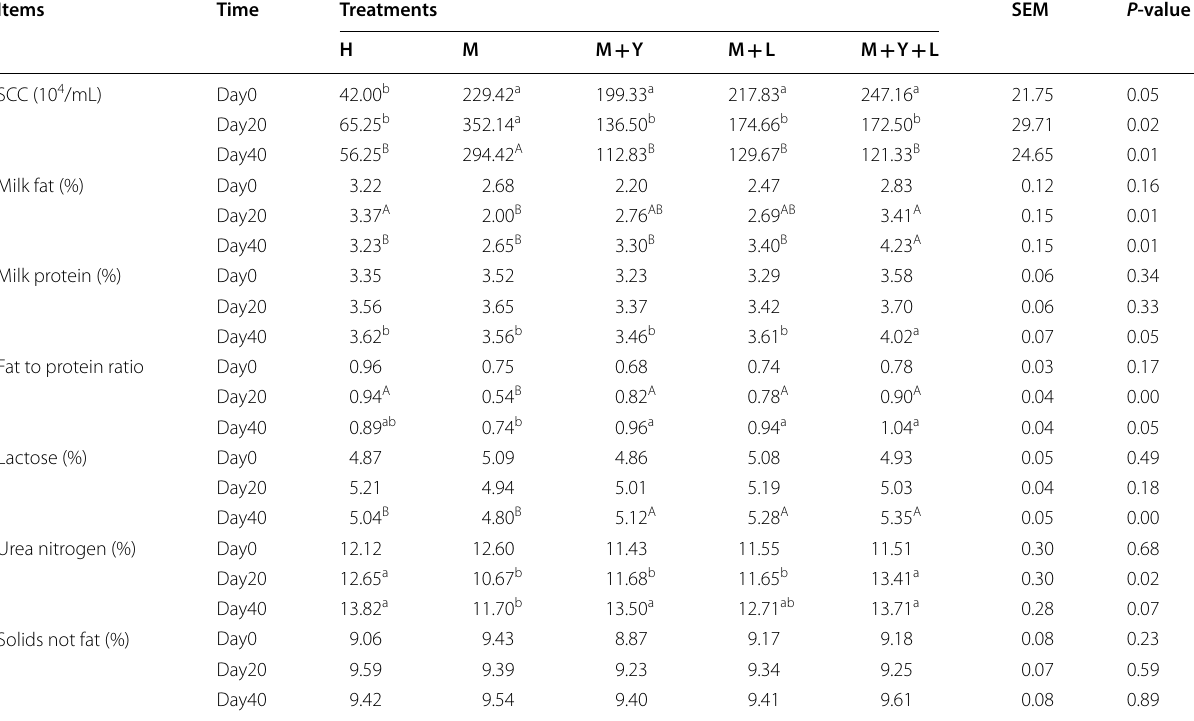
In dairy cows, SCC and milk of inferior are important predictors for mastitis abc Means in the same row with significant difference ( P < 0.05) ABC Means in the same row with extremely significant difference ( P <